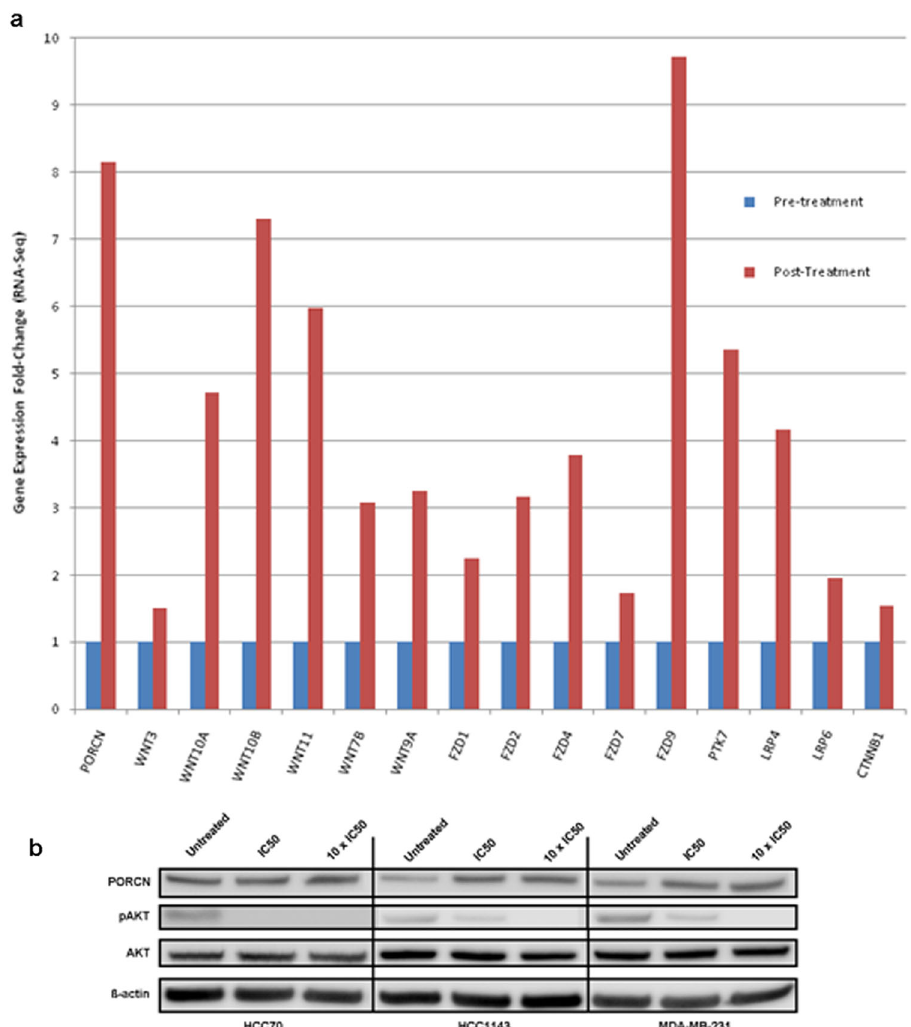
Fig. 2 a RNA expression of Wnt pathway molecules after buparlisib treatment of the TNBC cell line MDA-MB-231. Cells were treated with buparlisib and RNA-seq (Ampliseq Transcriptome, see methods) was performed on extracted RNA before and after treatment. Genes in the WNT pathway that were observed to have a change in expression include the protein target of WNT974, porcupine (PORCN), as well as the Wnt ligands, FZD receptors, PTK7, LRP4/6, and beta-catenin (CTNNB1). b Western blot of porcupine (PORCN), phosphorylated-AKT (p-AKT Ser 473), total AKT, and beta-actin (loading control), before and after treatment of three TNBC cell lines with buparlisib. The western blot shows signi fi cant induction of PORCN protein after treatment with buparlisib across all three cell